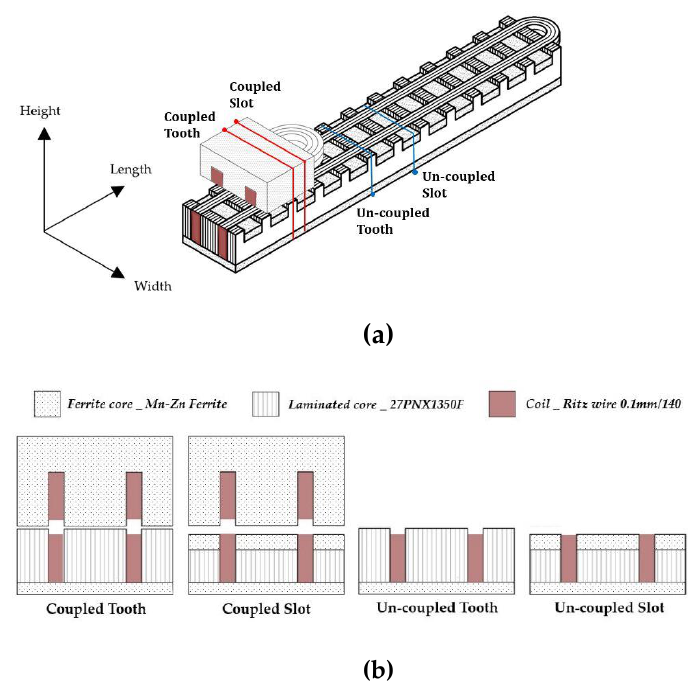
Figure 6. Configuration of the WPT device: ( a ) total shape; ( b ) cross section. Table 1. Dimensions and specification of a wireless power transfer device.